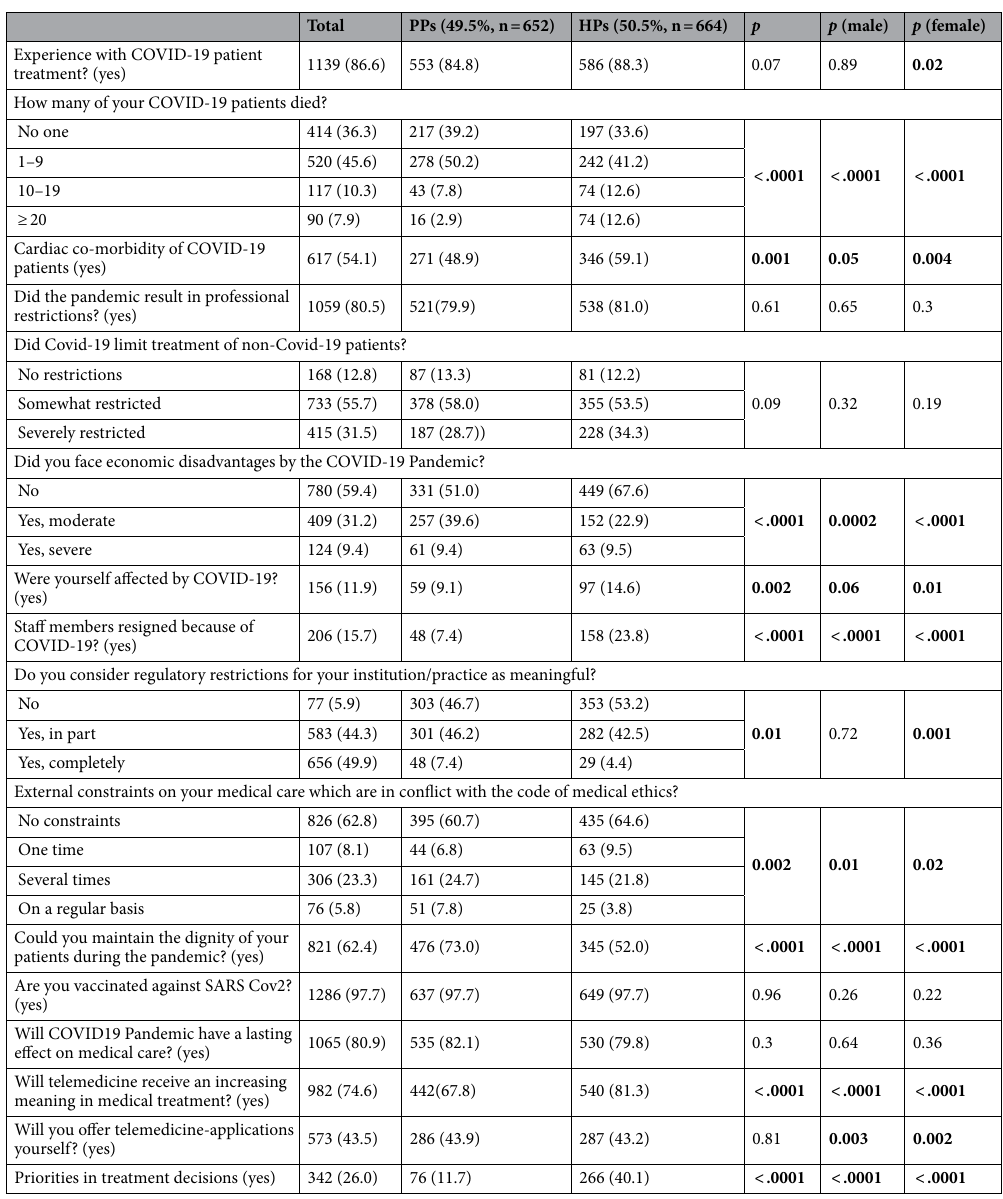
Table 1. Impact of COVID-19 cases on treatment and professional life of physicians, stratified for physicians in private practice (PPs) (n = 652) and hospital (HPs) settings (n = 664) in N (%) (Total, N = 1316). * p value for differences between PPs and HPs; p values obtained from chi-square-test for categorical variables and Wilcoxon–Mann–Whitney test for continuous variables. Significant values are in